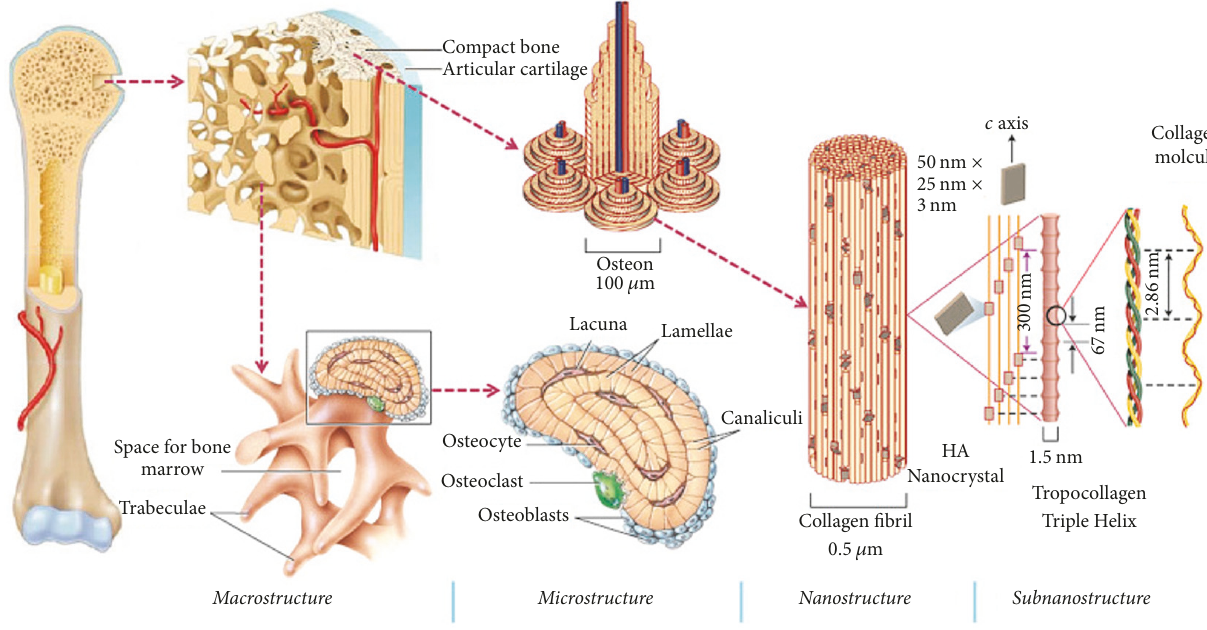
Figure 2: Ordered arrangement of bone structure. Copyright @Elsevier, reproduced with permission from Elsevier